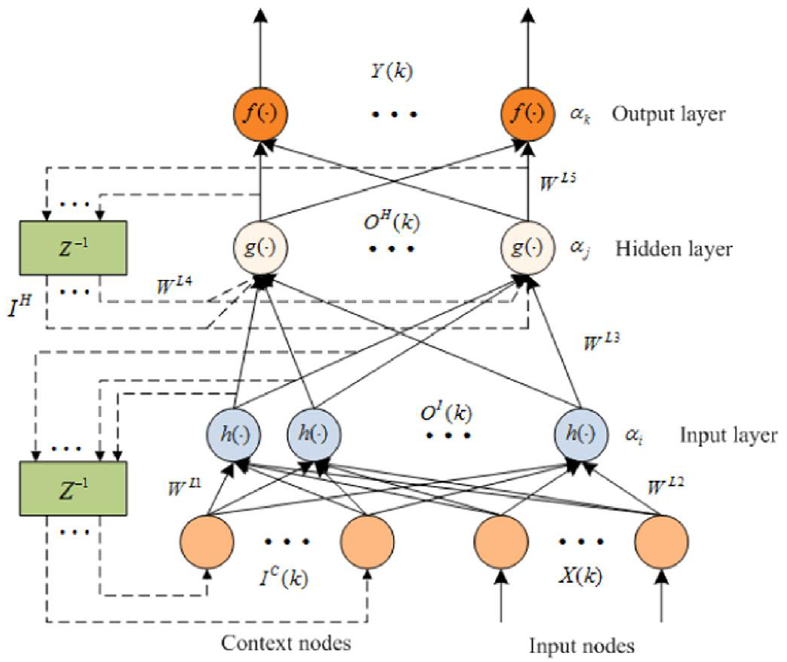
Figure 6. The structure of the Elman neural network.